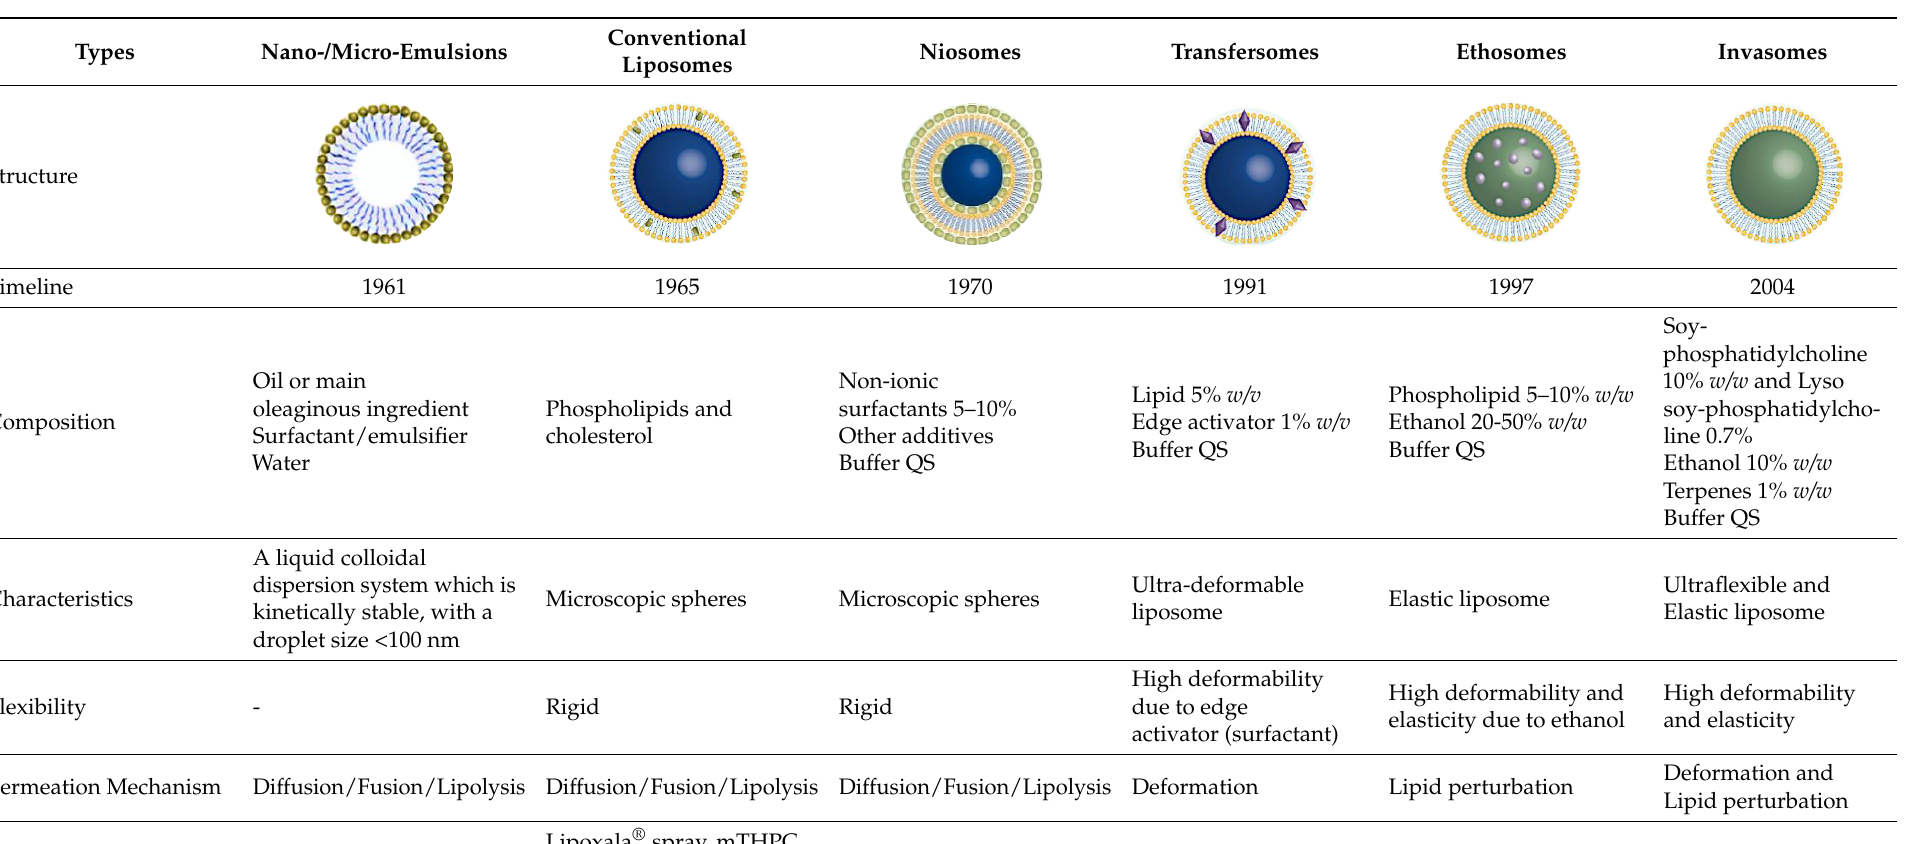
Table 1. Current lipid-based nano- and micro-vesicular systems in use for topical and transdermal drug delivery in photodynamic therapy. Abbr.: 5-aminolevulinic acid (ALA), meso-tetra (hydroxyphenyl)-chlorin (mTHPC), benzoporphyrin derivative monoacid ring A (BPD-MA), zinc phthalocyanine (ZnPc).